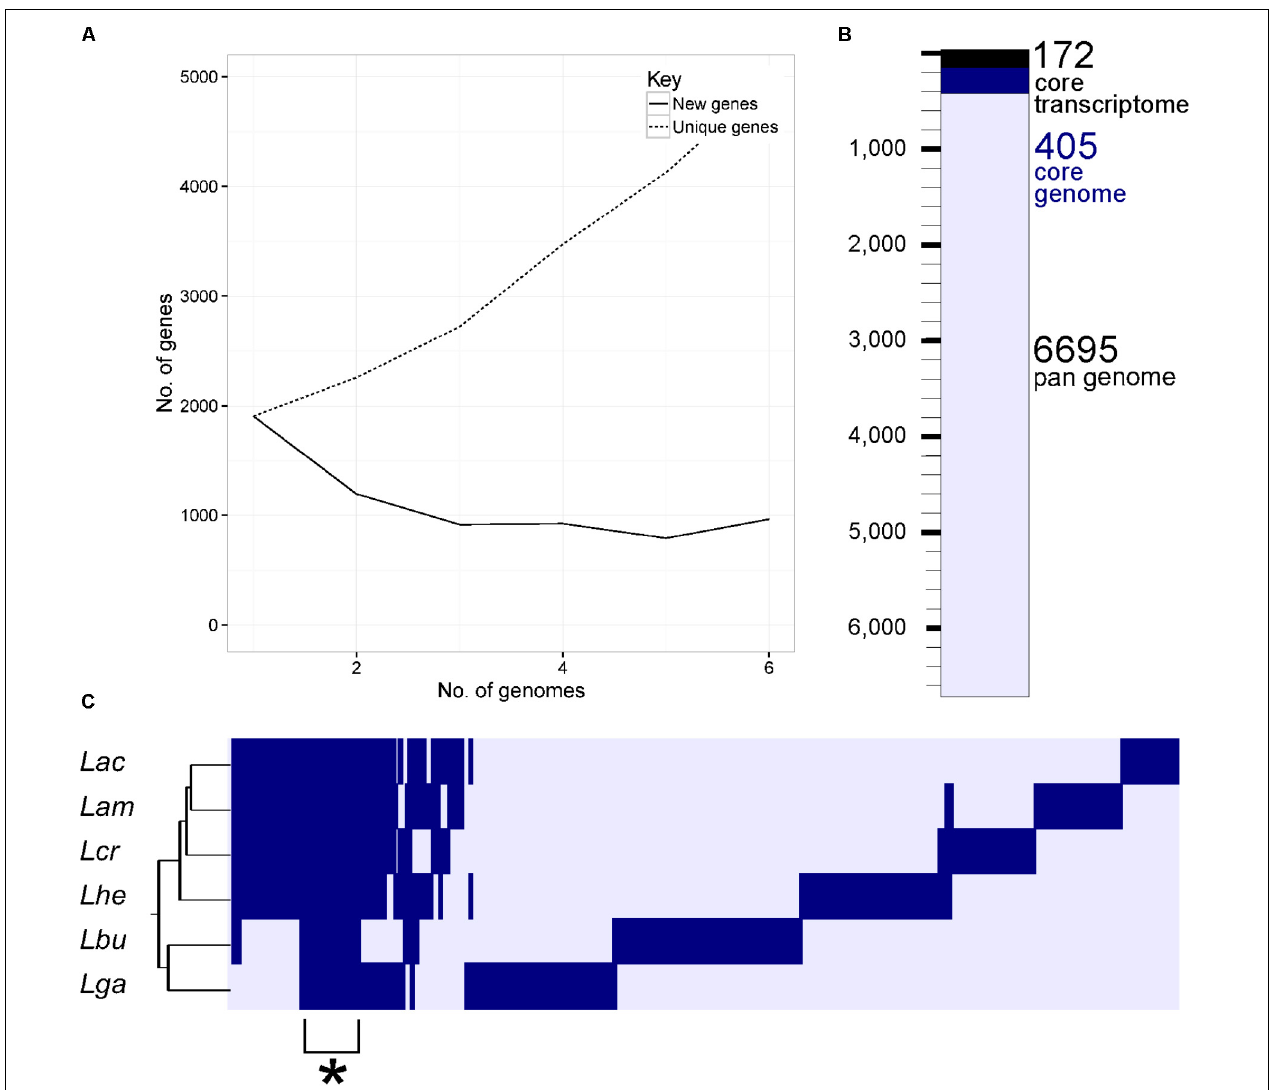
FIGURE 3 | The core genome of the L. acidophilus complex. A rarefaction curve (A) demonstrates the number of new genes added by the addition of each genome (solid line) and the cumulative number of genes (dashed line) in the pan genomes as additional genomes are added to the analysis. The waterfall plot in (B) depicts the number of unique genes in the pan genome (light blue bar), the number of genes in the core genome (dark blue bar), and the number of genes in the core transcriptome (black bar). The core transcriptome consists of genes from the core genome that occur in the 90% of mRNA range in each organism. The cluster diagram (C) shows genes present (dark bar) and genes absent (light bar) in each genome; the cluster demarked with a ( ∗ ) is the core genome. The three letter code for each organism is as follows: Lac ( L. acidophilus ), Lam ( L. amylovorus ), Lcr ( L. crispatus ), Lhe ( L. helveticus ), Lbu ( L. bulgaricus ), and Lga ( L. gasseri